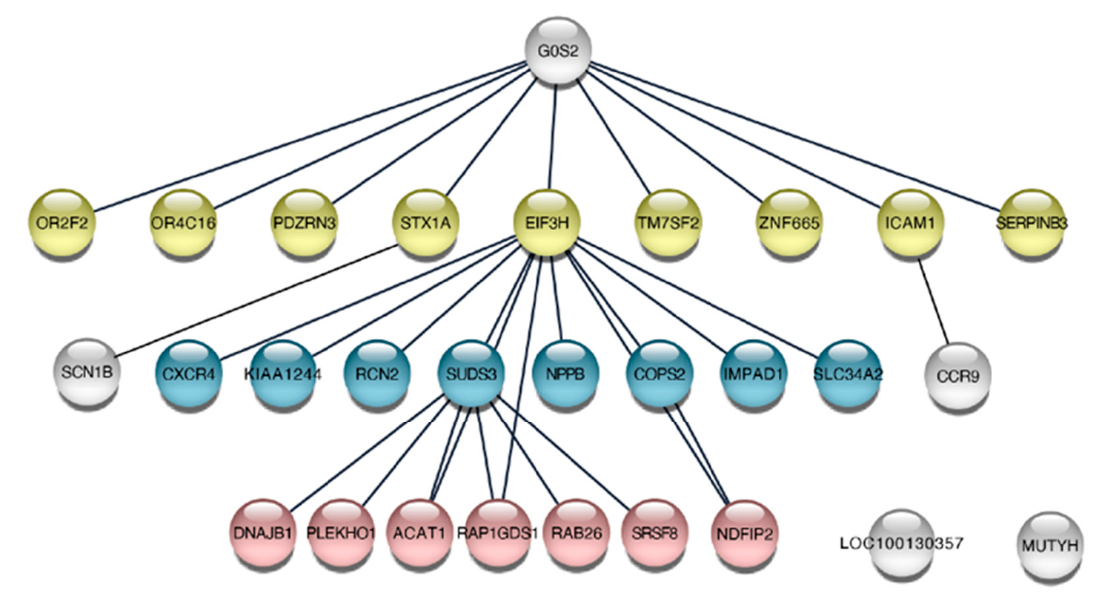
Figure 9. G0S2, EIF3H, SUDS3 master regulators. Regulatory hierarchy of twenty-nine shRNA hits common to DF/myc(CTG) 100 eGFP/TK, DF/myc(CTG) 100 eGFP/CMV-TK, and DF/myc(PU) 58 eGFP/CMV-TK cell lines.